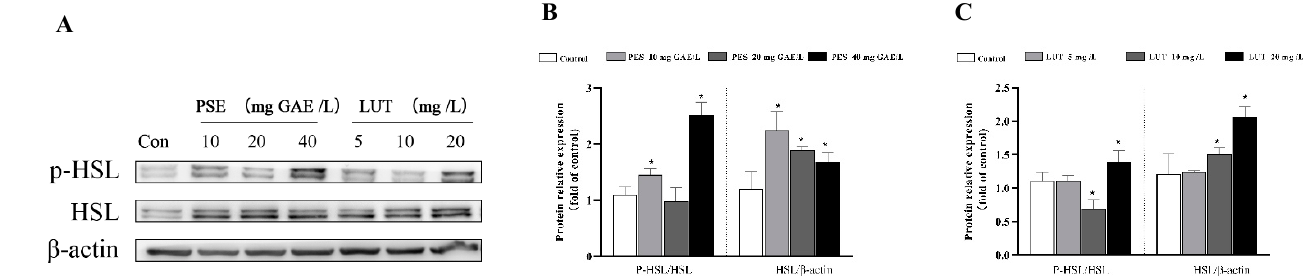
Figure 7. PSE and LUT modulated the expression of the phosphorylation of HSL in the 3T3-L1 adipocytes. ( A ) The Western blot results for the HSL phosphorylation. The quantification of pHSL/HSL and HSL/ β -actin after ( B ) PSE and ( C ) LUT treatment. The data are presented as the mean ± SD from three independent experiments. * Significant differences are indicated by p < 0.05.